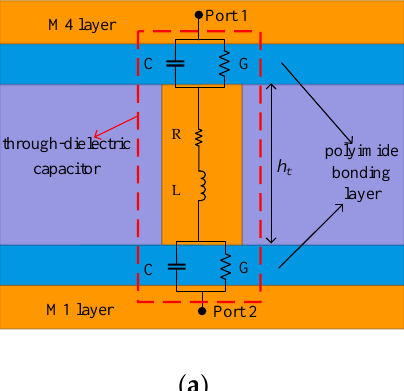
Figure 8. Structure of TDC in the designed filter: ( a ) Cross-section schematic view with the main parasitic components; ( b ) Equivalent lump model.